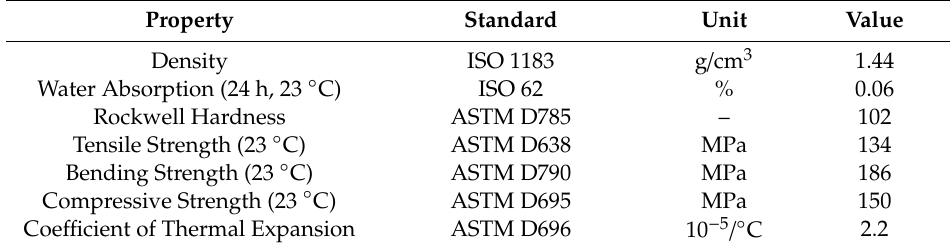
Table 1. Main physical properties of carbon fiber reinforced polyetheretherketone (CF-PEEK) composite.